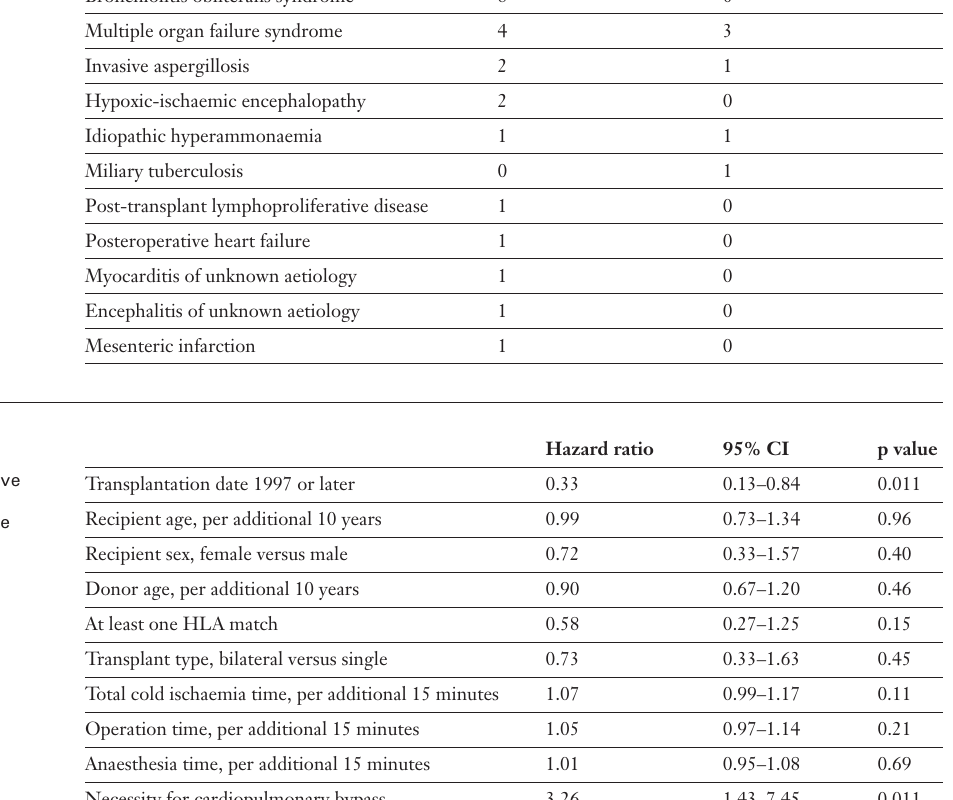
Causes of death.